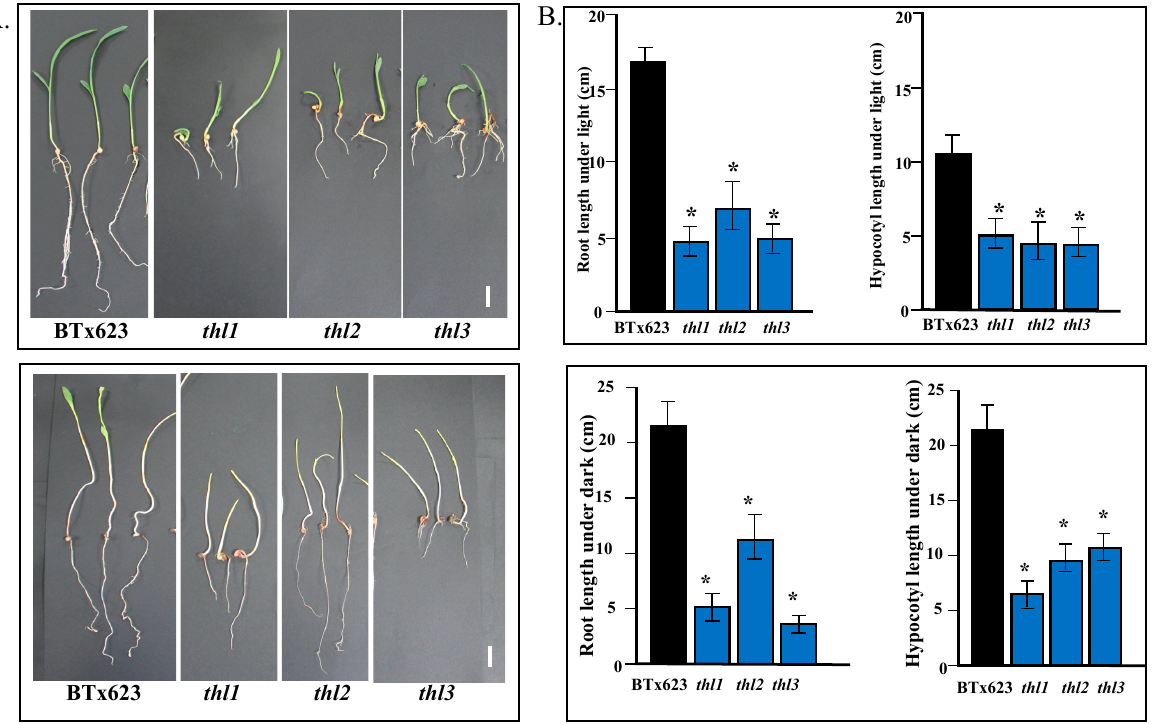
Figure 4. Light- and dark-grown seedlings of BTx623 and mutants thl1 , thl2 , and thl3 were compared for root length and hypocotyl length. ( A ). One week to ten days old BTx623, thl1 , thl2 , and thl3 seedlings grown under light conditions ( upper lane ). Scale bar: 1 cm. BTx623, thl1 , thl2 , thl3 seedlings grown for 1 week to 10 days under dark conditions ( lower lane ). Scale bar: 1 cm. ( B ). Root length and hypocotyl length of BTx623 seedlings were compared with thl1 , thl2 , and thl3 seedlings under light ( upper panel ). Root length and hypocotyl length of the seedlings under light was taller in BTx623 than in thl1 , thl2 , and thl3 . Root length and hypocotyl length of BTx623 was compared with thl1 , thl2 , and thl3 seedlings grown under dark ( lower panel ). Root length and hypocotyl length of the seedlings under dark was taller in BTx623 than in thl1 , thl2 , and thl3 . * Represents significant difference.